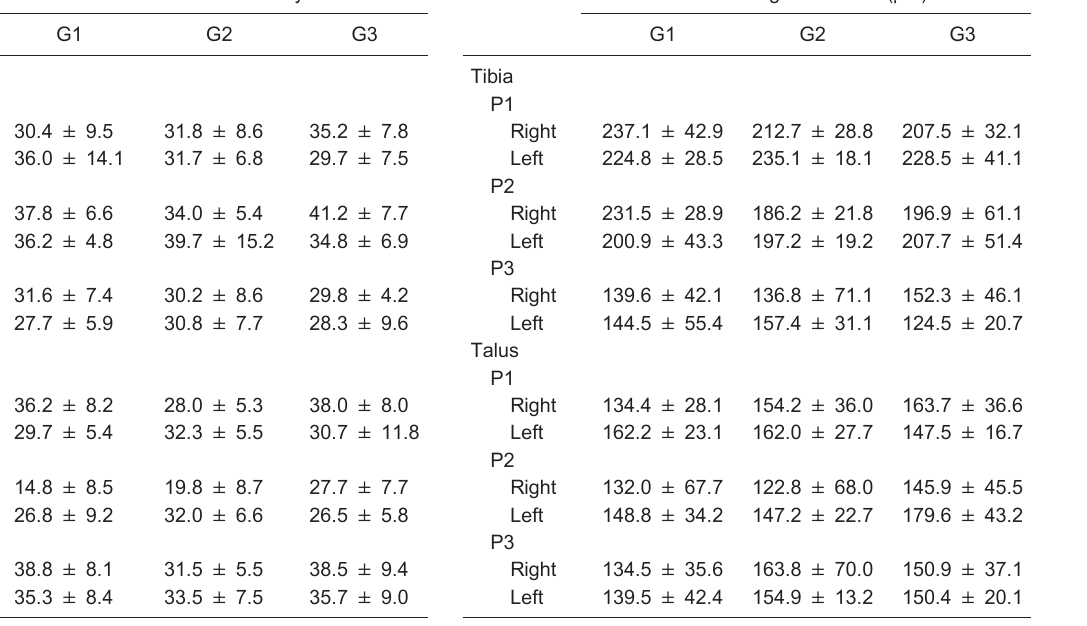
Number of chondrocytes